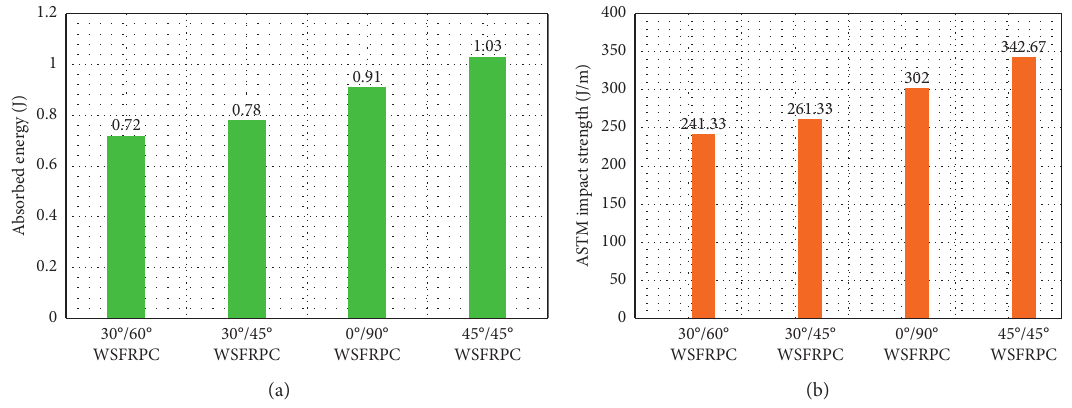
Figure 8: Absorbed energy (a) and impact strength of WSFRUPC (b) (imported from Excel